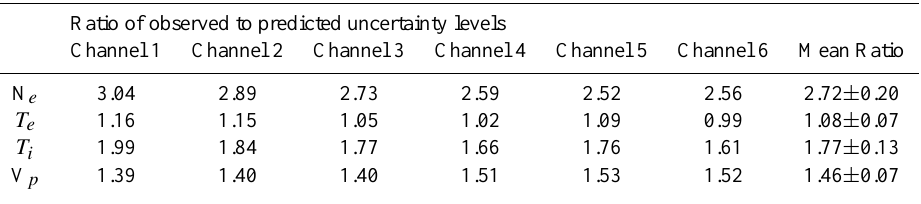
Table 1. Ratios between observed and predicted uncertainty levels for the four main EISCAT derived parameters. These values are given by the gradients of least-squares fits to the data from six separate frequency channels in the CP-4-A data taken by the Tromsø UHF radar between 2–3 October